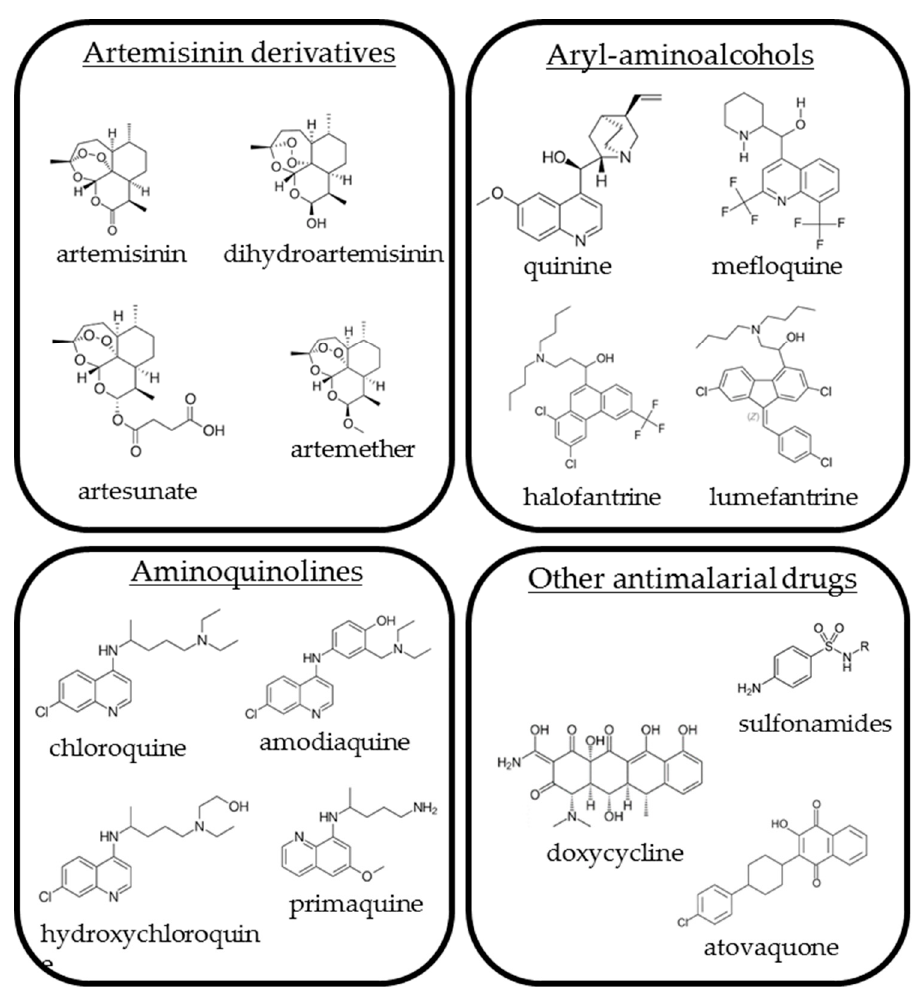
Figure 1. Chemical structures of the compounds described in the text.